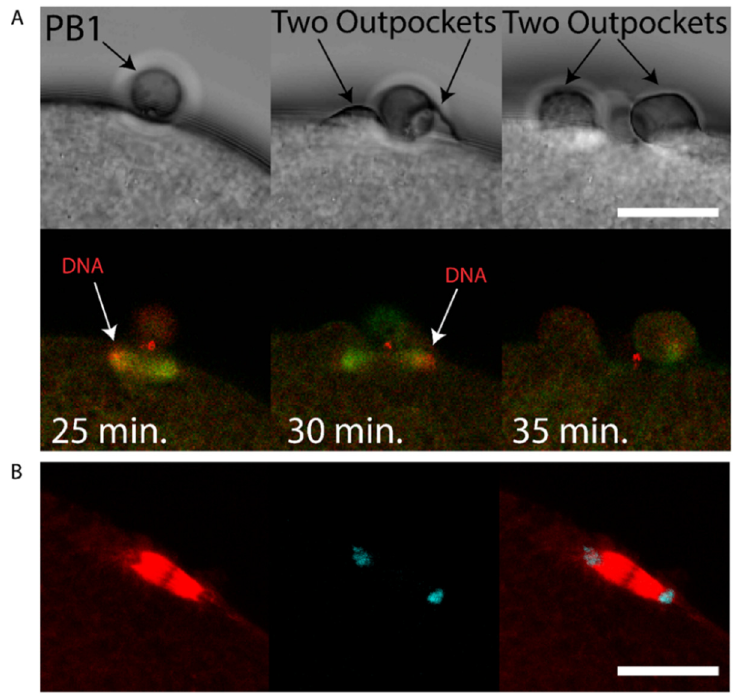
Figure 5. Failed rotation of second meiotic spindle giving two PB2 outpockets. ( A ) Unfertilized eggs were injected with mRNAs encoding Ens::3GFP (microtubules green) and Kif2::mCherry (chromosomes red) mRNA. Two outpockets are shown in the second and third bright field images respectively (arrows). Please note that the second meiotic spindle fails to rotate and two outpockets form above both sets of chromosomes following Ana II (see 24–31 min. on Supplementary Movie S8). Note also that Kif2::mCherry also labels the midbody (prominent red staining near PB1). Scale bar = 20 µ m. n = 5 / 5 examples of parallel spindles. See Supplementary Movie S8 for the full data-set. Another example of two simultaneous PB2 outpockets is shown in Supplementary Movie S7. ( B ) Fertilized eggs were fixed and labelled with anti-Tubulin (red) and stained with DAPI (blue). Confocal images of a spindle positioned parallel to the egg cortex in anaphase. Scale bar = 20 µ m, n = 5 examples of parallel MII